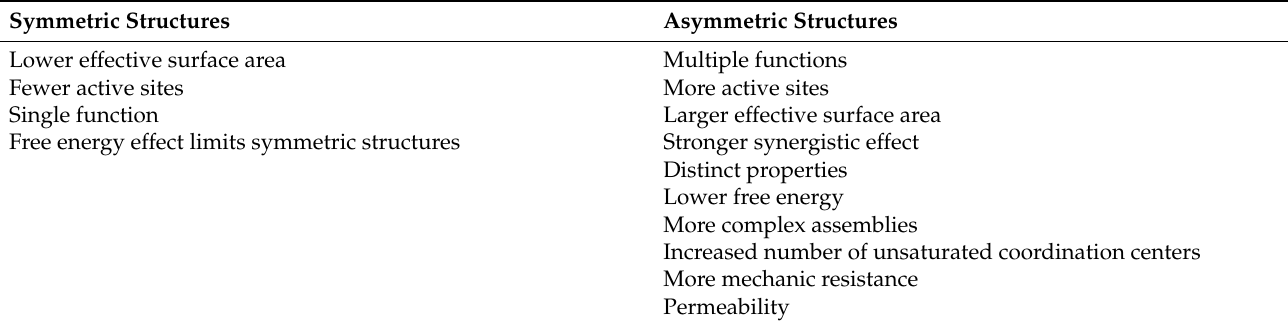
Table 1. The comparison of advantages and disadvantages between symmetric and asymmetric nanostructures.